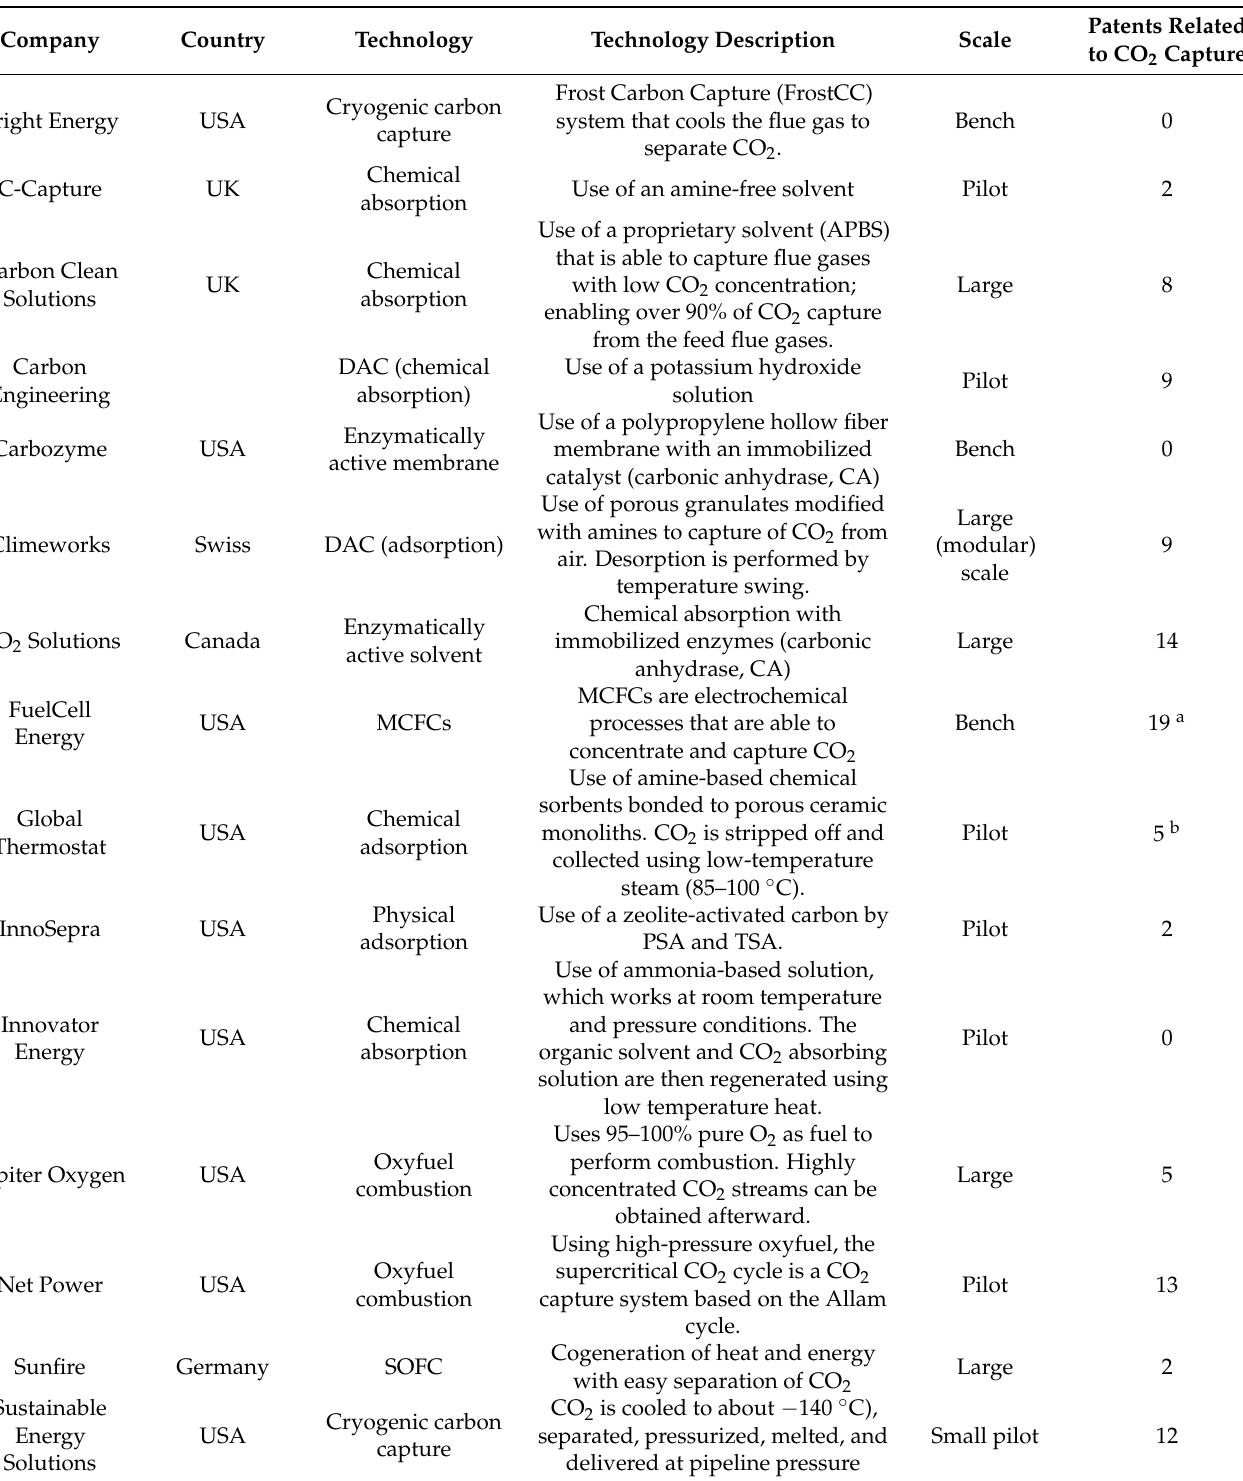
Table 16. Main technological players in the fields of CO 2 capture and purification for manufacture of chemicals.